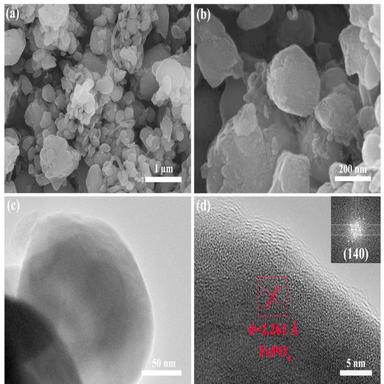
(a, b) SEM and magnified SEM patterns, and (c, d) TEM and HRTEM patterns for FPO samples.